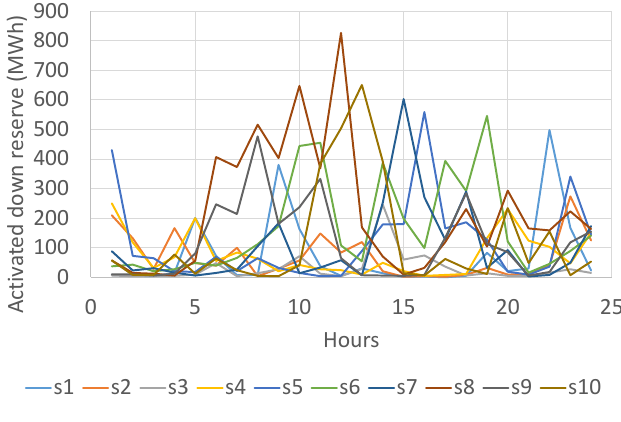
Figure 5. Down reserve activation per scenario ( R a ↓